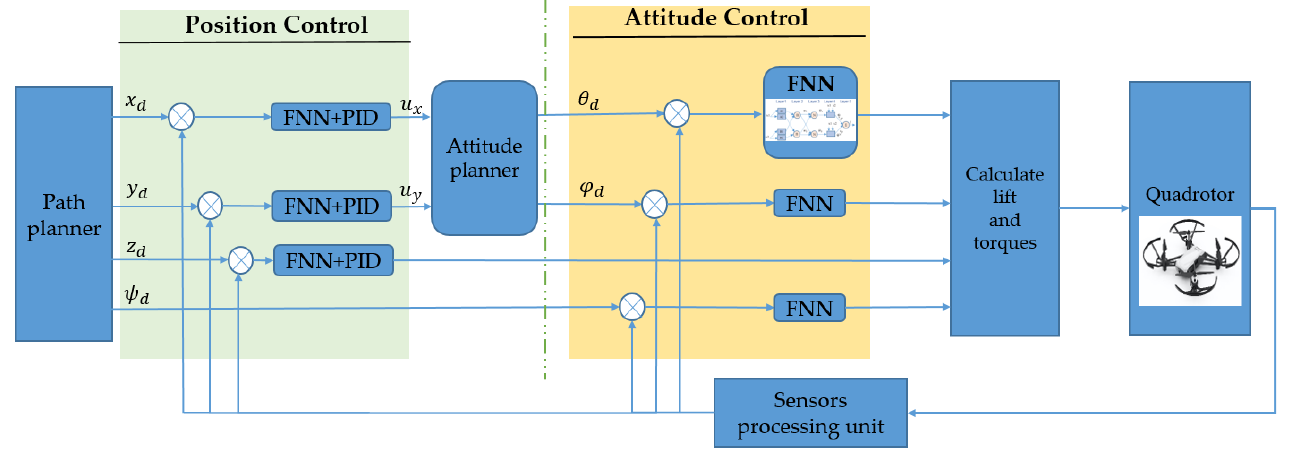
Figure 2. The block diagram of the control system.